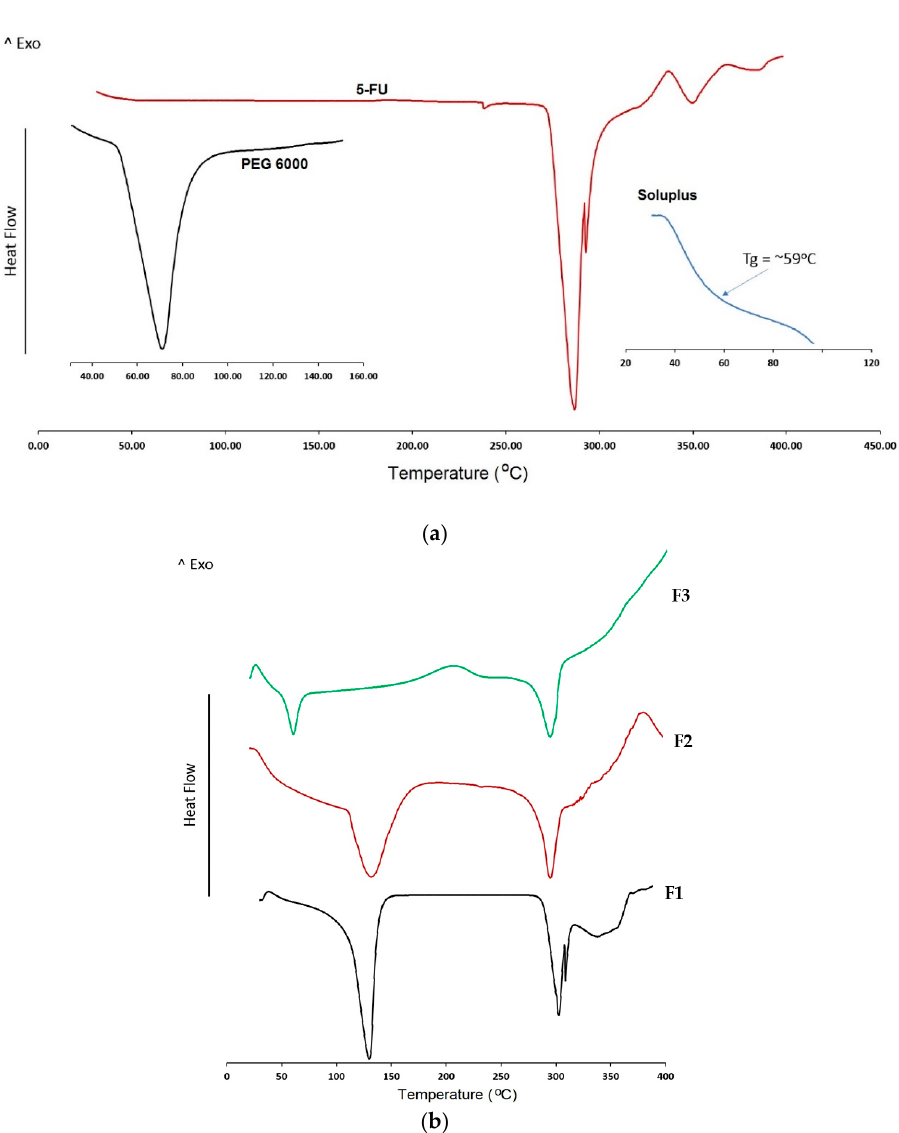
Figure 5. Differential scanning calorimetry (DSC) data of ( a ) bulk drug, Soluplus, and PEG 6000, ( b ) scaffold formulations (F1–F3).